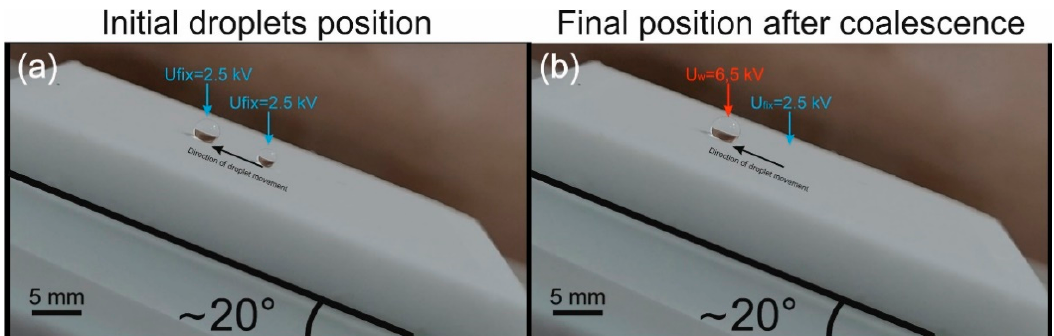
Figure 6. Demonstration of the possibility of manipulating water droplets on inclined PMD (up to 20°) by the example of coalescence; ( a ) fixation of droplets on the superhydrophobic region (2.5 kV), ( b ) coalescence of droplets is carried out by increasing the voltage on one of the CE to 6.5 kV. On an inclined PMD, the mode of droplet coalescence can also be achieved, which is the second way, when both droplets are initially held on the PMD by the application of holding voltages U fix = 2.5 kV. Then there is a pulsed increase in voltage to 6 kV under the selected motionless droplet, as a result of which the second droplet is attracted to it.